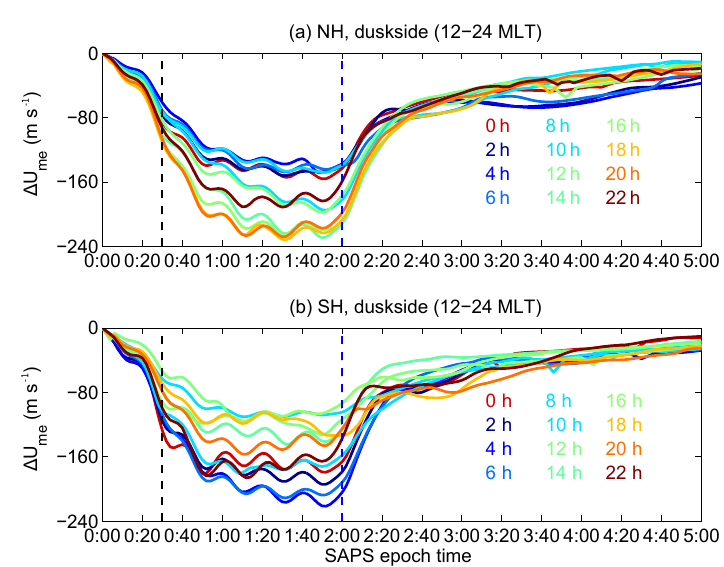
Figure 9. Time variation of the strongest disturbance neutral wind in the dusk sector (18:00–24:00MLT). A sine-wave oscillation with a 20min time period and 8kV amplitude is added to the SAPS peak potential in the steady case. Different colors represent SAPS onset times at 2h intervals from 00:00 to 22:00UT. The SAPS potential in the steady case attains extreme values around 00:30epoch time, as indicated by the black vertical dashed line. SAPS become zero around 02:00epoch time, as indicated by the blue vertical line. The top panel is for the Northern Hemisphere, and the bottom panel is the Southern Hemisphere.